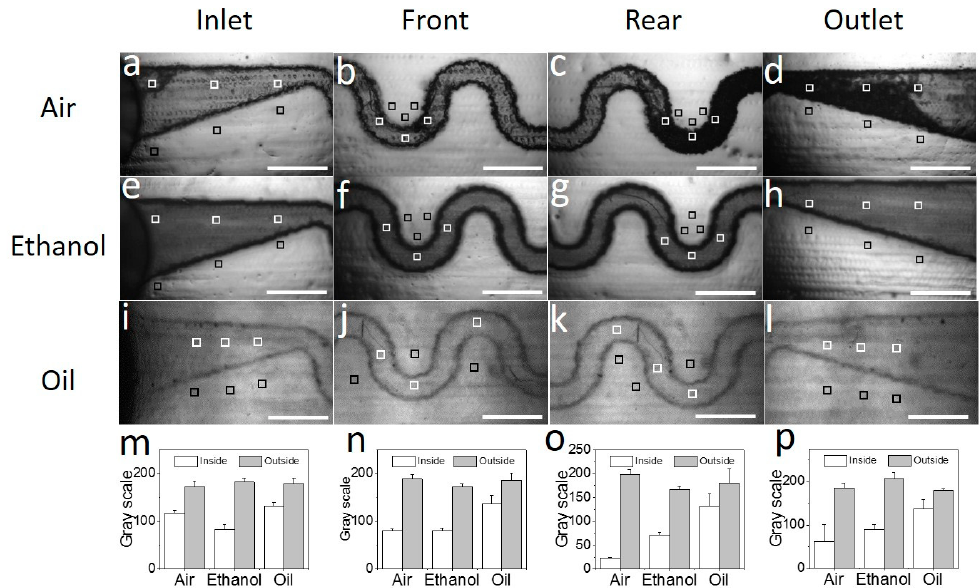
Figure 3. Inner sacrificial materials removal with three removers. ( a – d ) Inject air into the heating chip and take pictures at the ( a ) inlet, ( b ) front part, ( c ) rear part, and ( d ) outlet under the microscope. ( e – h ) Inject ethanol into a hot bath with the chip and take pictures at the ( e ) inlet, ( f ) front part, ( g ) rear part, and ( h ) outlet under the microscope. ( i – l ) Inject vegetable oil into a hot bath with the chip and take pictures at the ( i ) inlet, ( j ) front part, ( k ) rear part, and (l ) outlet under the microscope. ( m – p ) Transmittance results at the ( m ) inlet, ( n ) front part, ( o ) rear part, and ( p ) outlet after processing by air, ethanol, and vegetable oil. The scale bar is 1 mm.